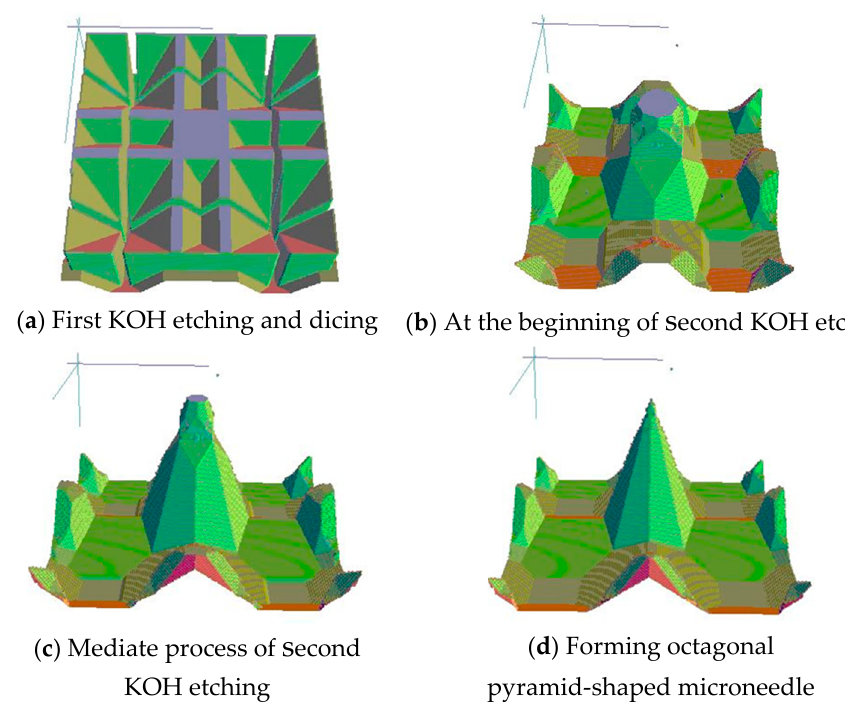
Figure 1. Simulation of second KOH etching.